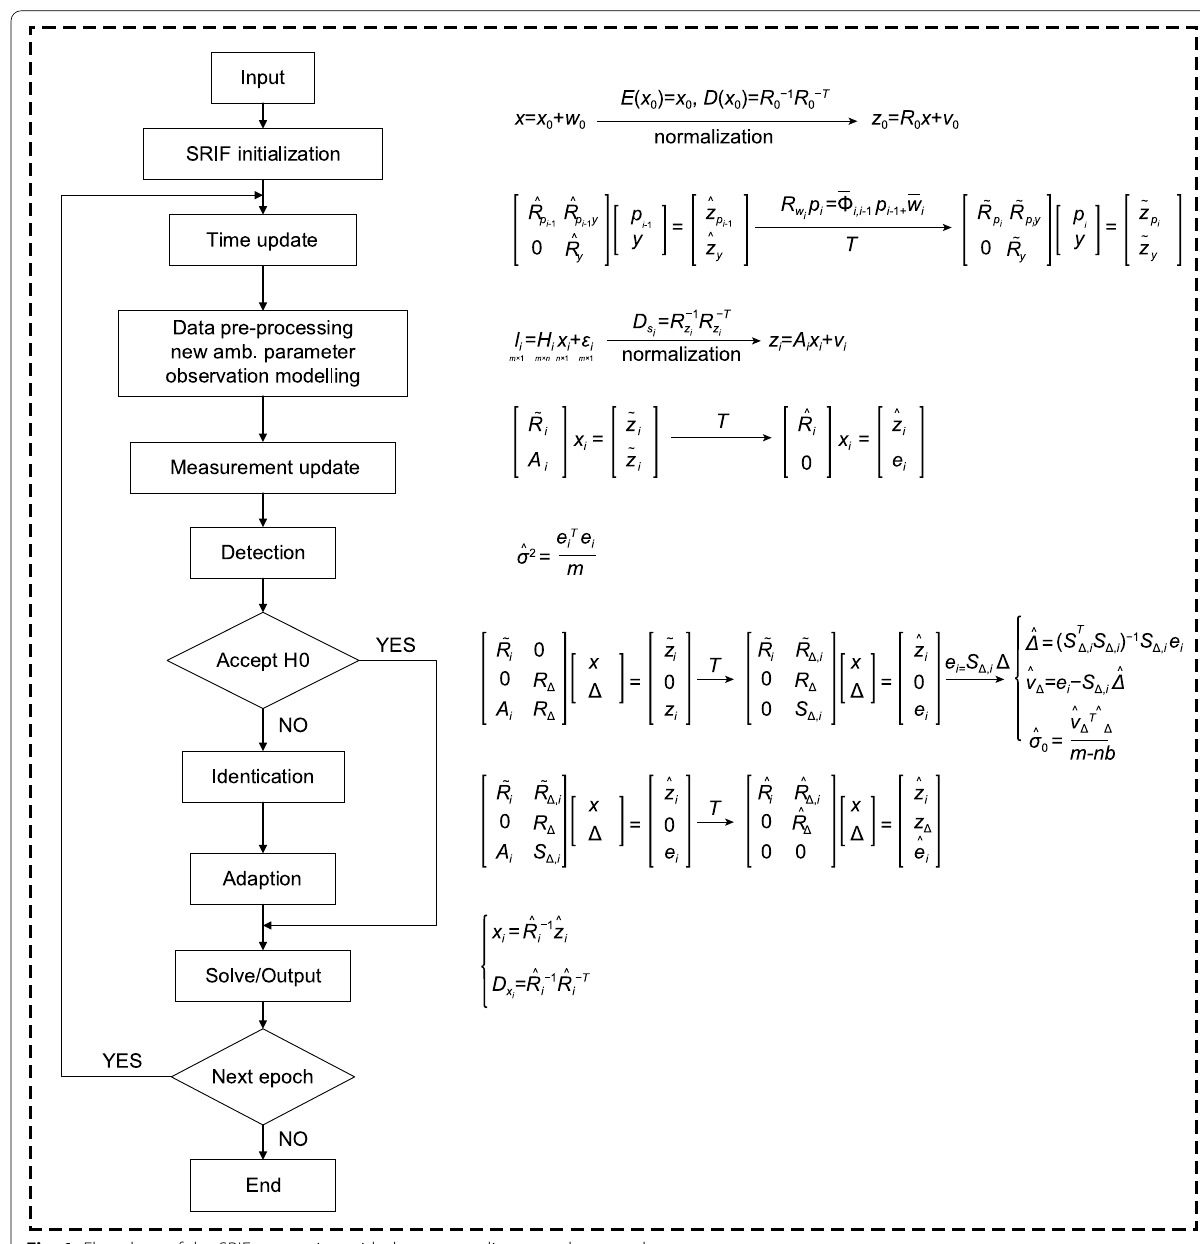
Fig. 1 Flowchart of the SRIF processing with the new quality control